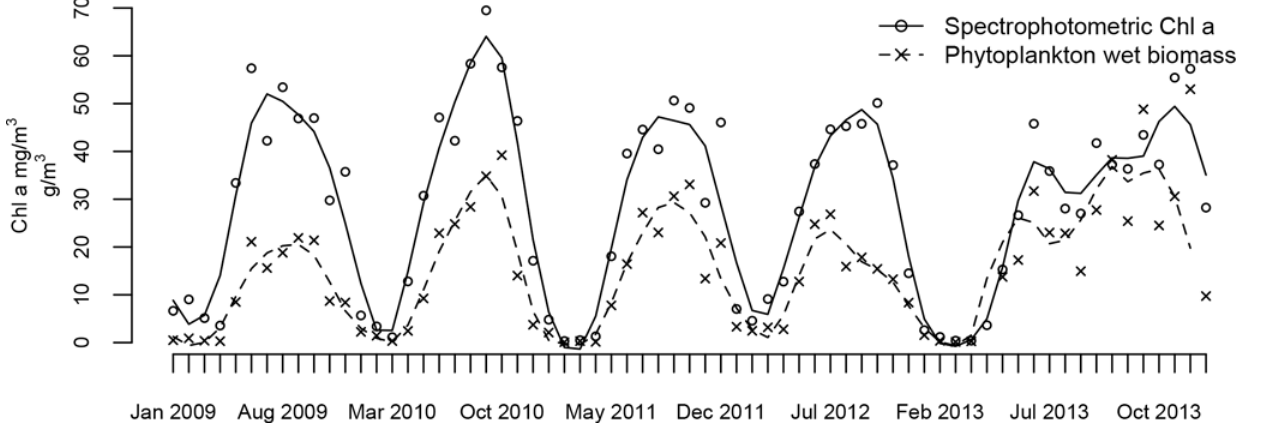
Fig 3. Spectrophotometric chlorophyll-a measurements during years 2009 – 2013. Loess curve is fit and overlaid on data.